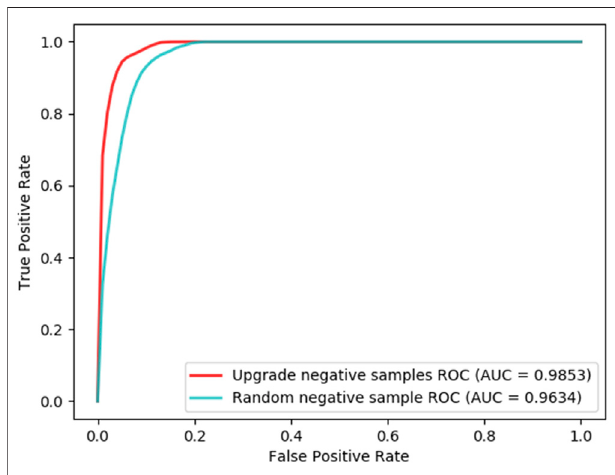
FIGURE 8 | ROC curves of Negative sample